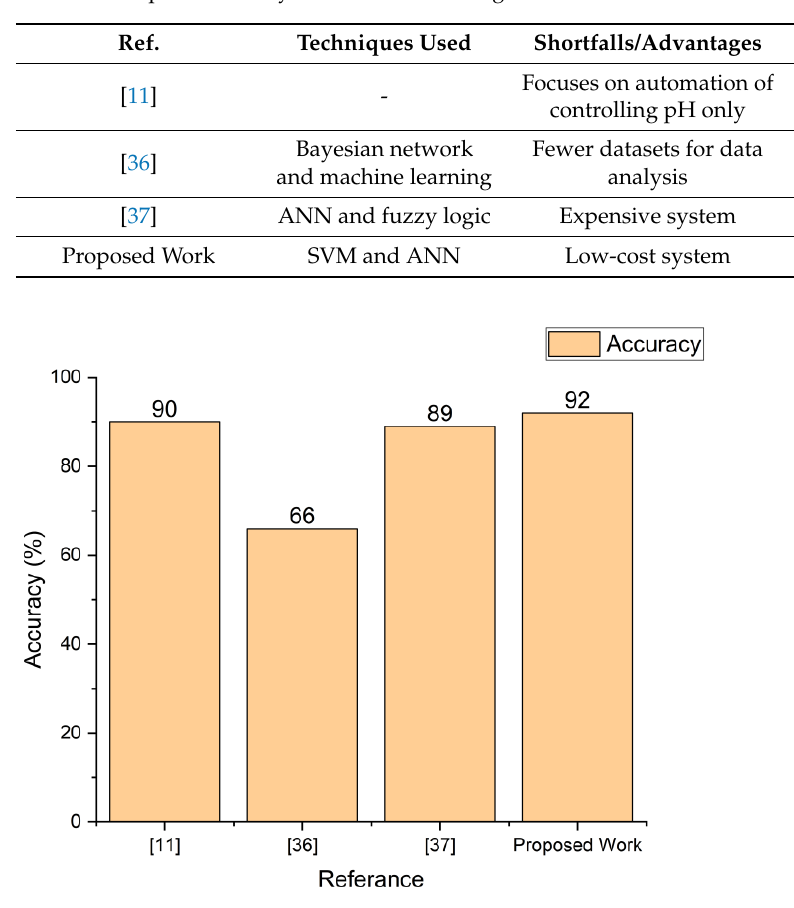
Figure 19. Representation of RMSE value.